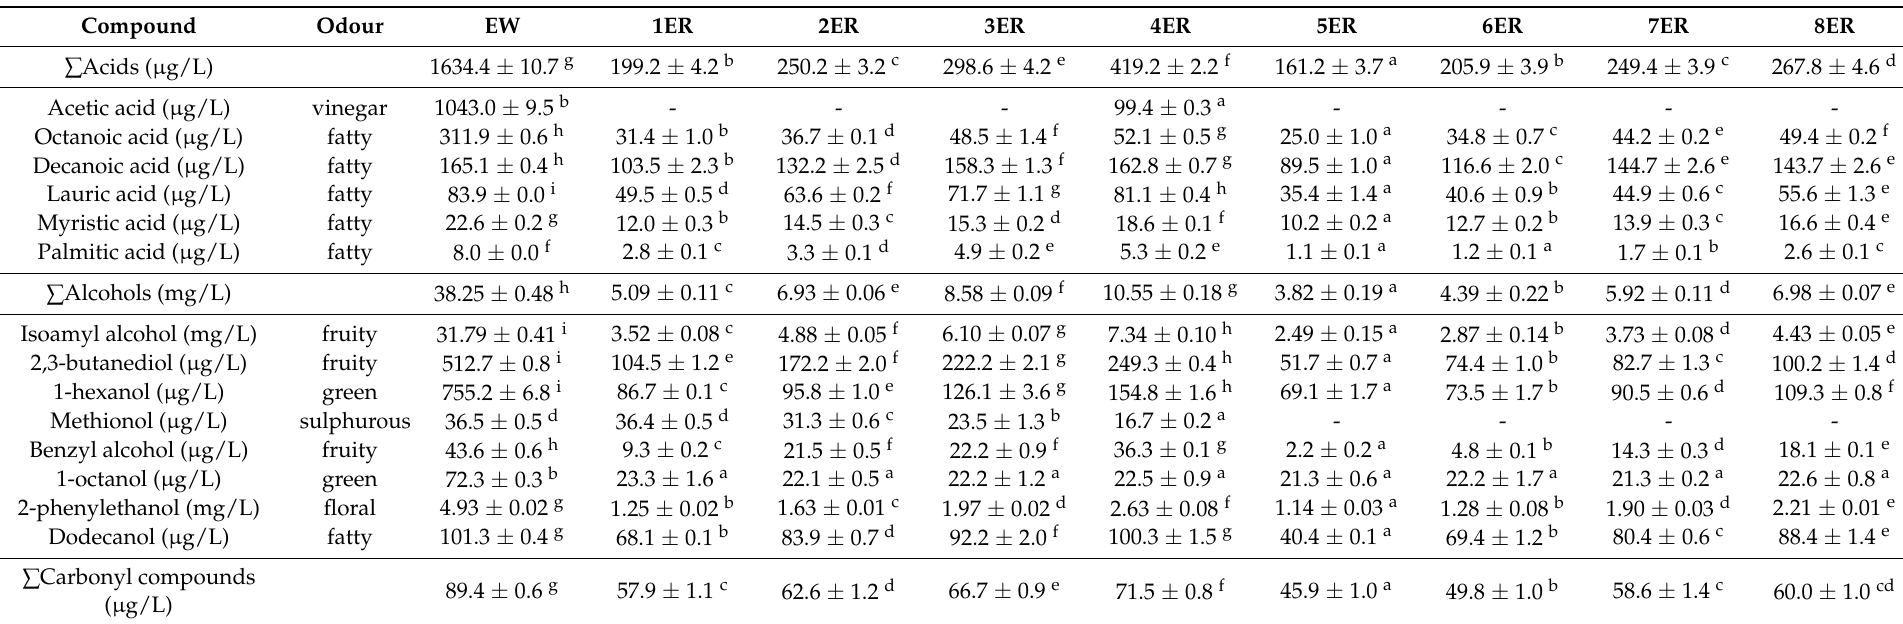
Table 2. Aroma compounds identified in the ecological Cabernet Sauvignon red wine and the RO retentates at 2.5, 3.5, 4.5 and 5.5 MPa, with cooling and without